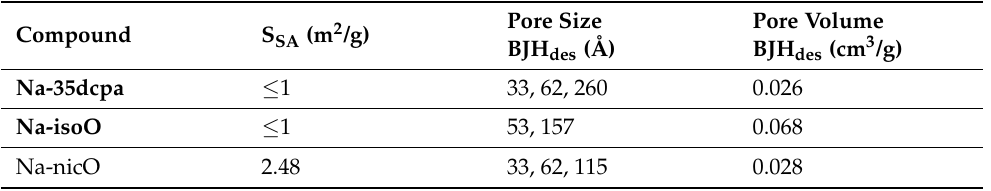
Table 3. N 2 physisorption-derived parameters characterizing the obtained samples (S SA —specific surface